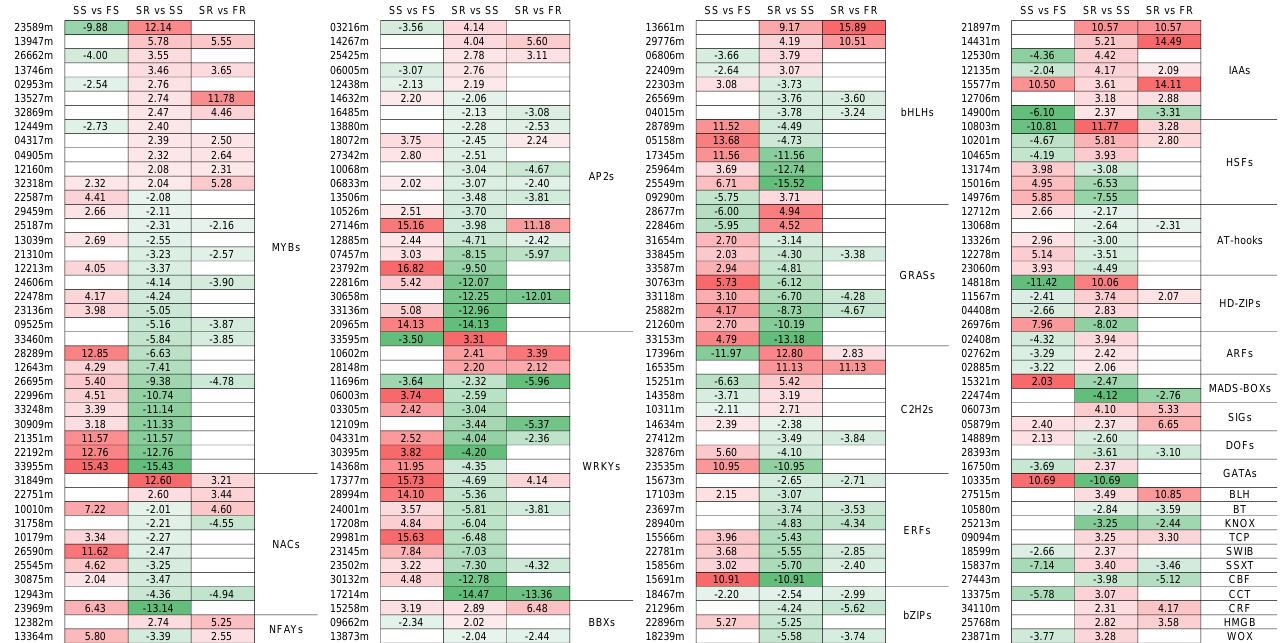
Figure 8. Heatmap of differentially expressed genes related to transcriptional regulation.